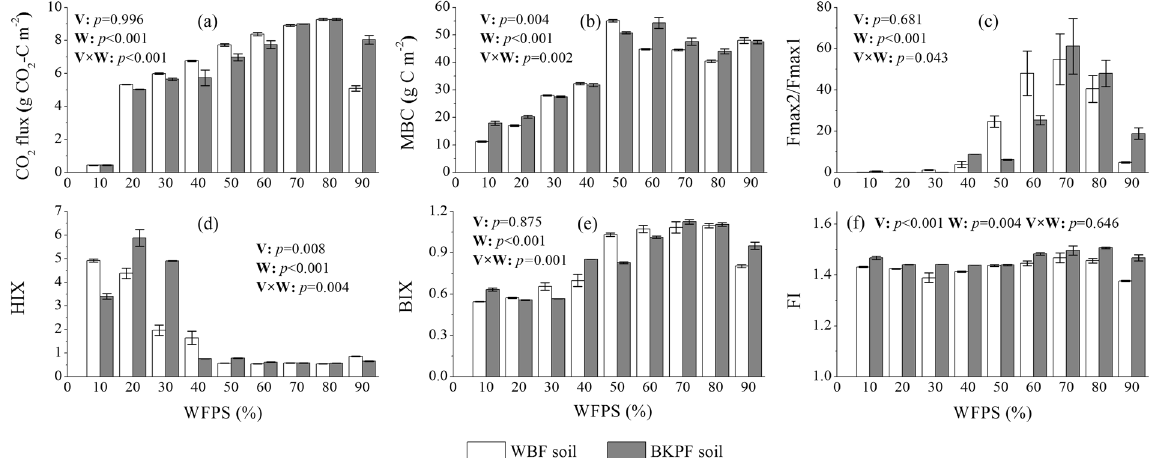
Figure 4. Effects of soil moisture on soil CO 2 flux, microbial biomass and spectral properties of DOM released into the soils during thawing. Significant levels for the interactive effects of vegetation type (V) and soil WFPS (W) on each index are shown inside each sub-plot. Error bars reflect the standard error of soil CO 2 flux, microbial biomass and spectral properties of DOM between replicates, respectively ( n = 3 for all